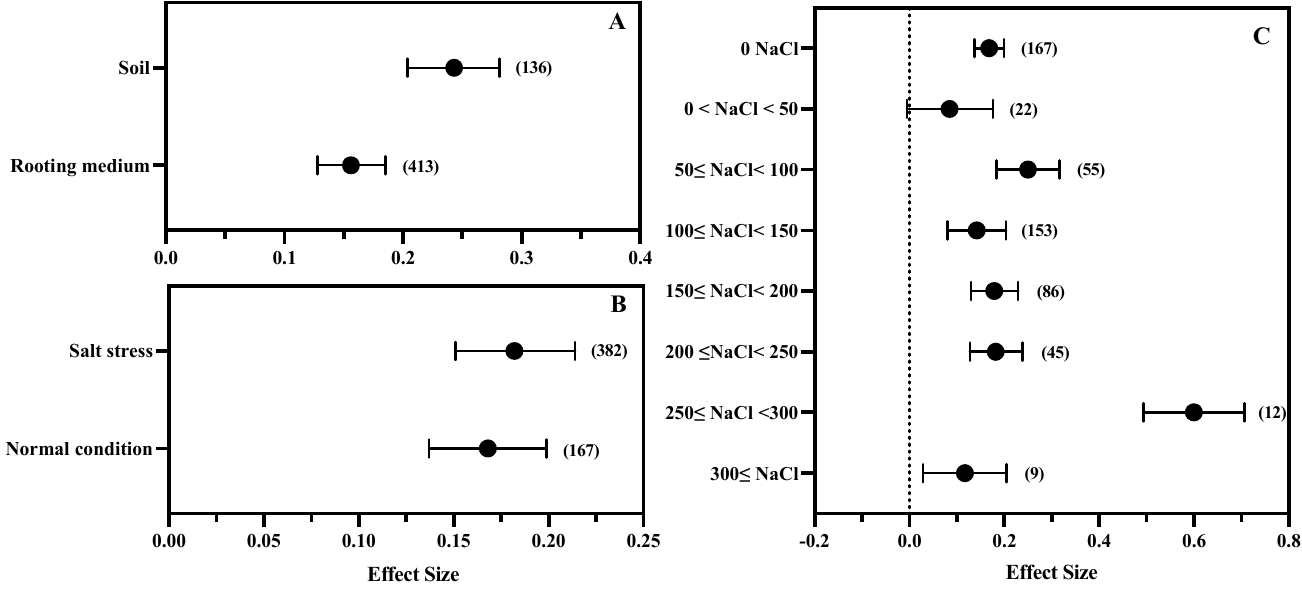
Figure 5. The effects of rooting environment ( A ), salt stress ( B ), and salt stress concentration ( C ) on MT regulation of plant growth under salt stress. The symbol represents the effect size, and the bars show the 95% bootstrapped confidence intervals. The values in the parentheses show the number of observations.